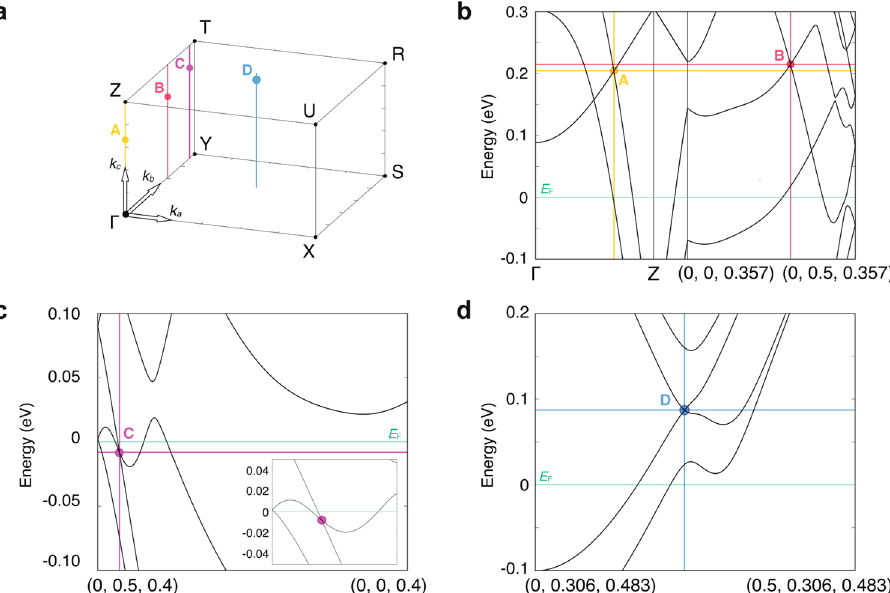
Fig. 4 Selected Weyl nodes (A-D) in the vicinity of the Fermi level in orthorhombic SrRuO 3 . a Position of the Weyl nodes in the irreducible part of the Brillouin zone. Vertical yellow, red, pink, and blue lines indicate the in-plane ( Γ – X – S – Y plane) positions of the Weyl nodes for easy viewing. The Weyl nodes are given in fractional coordinates as A = (0, 0, 0.332), B = (0, 0.307, 0.357), C = (0, 0.464, 0.4), and D = (0.233, 0.306, 0.483). b – d Band structures for the ferromagnetic ground state with spin – orbit coupling as obtained from GGA + U calculations with U = 2.6 eV and J = 0.6 eV. In b – d , the intersection of the straight lines represents the Weyl nodes. E F stands for the Fermi